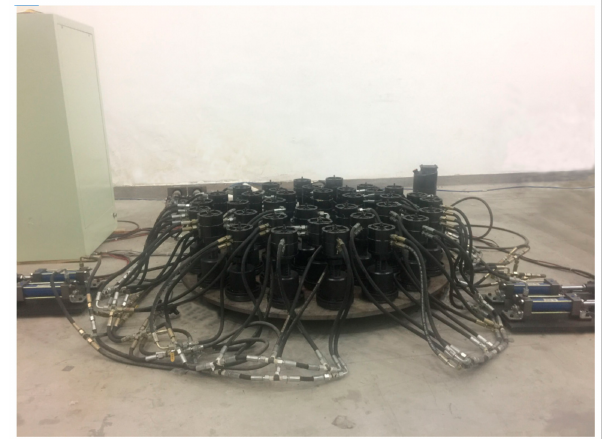
Figure 14. Experimental prototype of the Flexible support system.